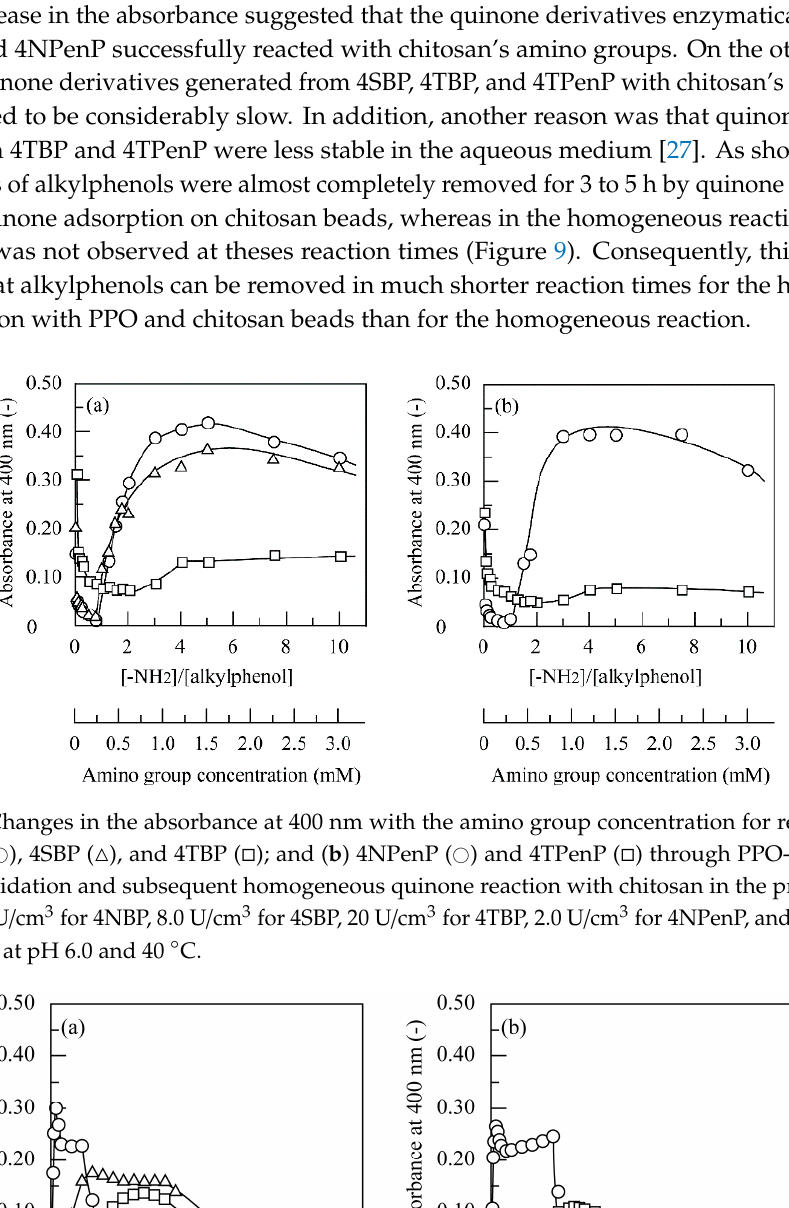
Figure 9. Time course of the absorbance at 400 nm for removal of ( a ) 4NBP ( ○ ), 4SBP ( △ ), and 4TBP ( □ ); and ( b ) 4NPenP ( ○ ) and 4TPenP ( □ ) through PPO-catalyzed quinone ) and 4TPenP ( (cid:3) ) through PPO-catalyzed quinone oxidation and subsequent oxidation and subsequent generation of insoluble aggregates in the presence of PPO at 3.0 generation of insoluble aggregates in the presence of PPO at 3.0 U / cm 3 for 4NBP, 8.0 U / cm 3 for 4SBP, U/cm 3 for 4NBP, 8.0 U/cm 3 for 4SBP, 20 U/cm 3 for 4TBP, 2.0 U/cm 3 for 4NPenP, and 30 U/cm 3 20 U / cm 3 for 4TBP, 2.0 U / cm 3 for 4NPenP, and 30 U / cm 3 for 4TPenP and chitosan at amino group concentrations of 0.225 mM for 4NBP, 4SBP, and 4NPenP and 0.45 mM for 4TBP and 4TPenP at pH 6.0 and 40 ◦